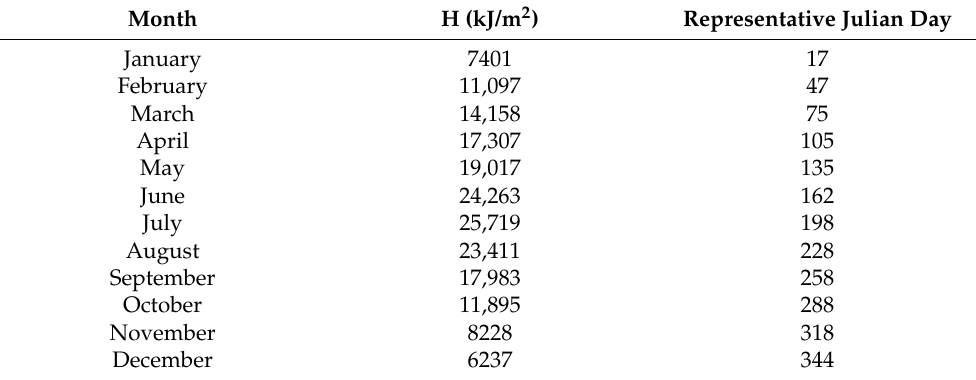
Table 1. Daily radiation on the horizontal plane (H) in C ó rdoba (Spain) taken from Posadillo et al. [46], and representative day considered for each month [42].